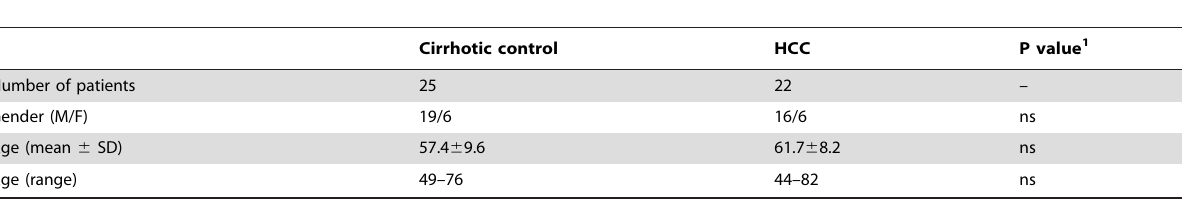
Table 1. Age and gender of patients from whom the HCC and cirrhotic samples were